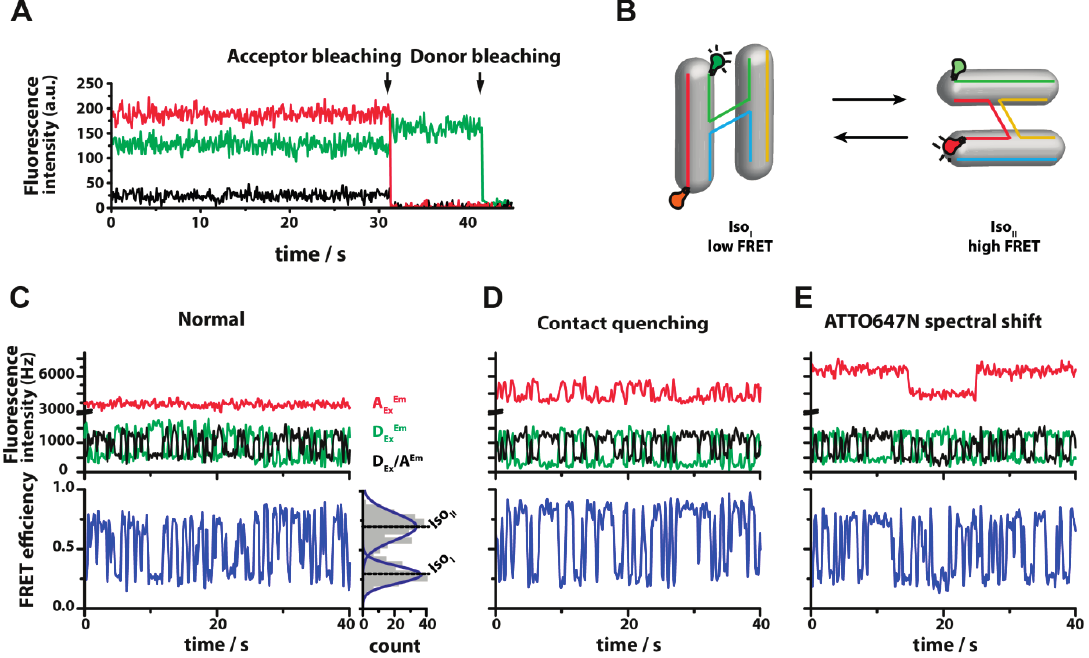
Figure 4. ( A ) Typical fluorescence transients of immobilized dsDNA labeled with a donor (Cy3B) and an acceptor dye (ATTO647N) allowing FRET. Using alternating laser excitation the acceptor emission upon acceptor excitation is recorded in addition to the FRET signal. The donor fluorescence is shown in green, the acceptor in red and the FRET intensity in black, respectively. Upon bleaching of the acceptor dye (32 s) no fluorescence is emitted by the acceptor and the donor fluorescence increases because of the inhibited energy transfer. Simultaneously, the FRET efficiency is reduced to zero. ( B ) The Holliday Junction (HJ) is composed of four single stranded DNAs that can adopt two different conformations, Iso I or Iso II (B). ( C ) Fluorescence time transient of a Cy3B-ATTO647N labeled HJ that undergoes conformational changes (TIRF measurement). The HJ is immobilized on a PEG surface in PBS with 200 mM MgCl 2 added to the buffer. The FRET efficiency (lower trace, blue) changes rapidly between a low FRET and a high FRET state and at the same time Cy3B and ATTO647N fluorescence intensities show an anti-correlated behavior (upper trace, donor in green, acceptor in red, FRET in blue) until the acceptor bleaches. A double-Gaussian fit of the histogram reveals FRET values E low FRET = 0.29 for conformation Iso I and E high FRET = 0.70 for conformation Iso II ; ( D ) The fluorescence of ATTO647N is quenched when it can directly interact with the donor fluorophore Cy3B. The quenching effect leads to a slightly decreased FRET efficiency [59] as compared to the FRET efficiency retrieved from a HJ with the FRET pair Cy3/Cy5 (a dye pair known to not directly interact); ( E ) ATTO647N can change its emission characteristics due to spectral shifts [39] potentially causing deviations in the FRET efficiency as shown by Di Fiori et al.